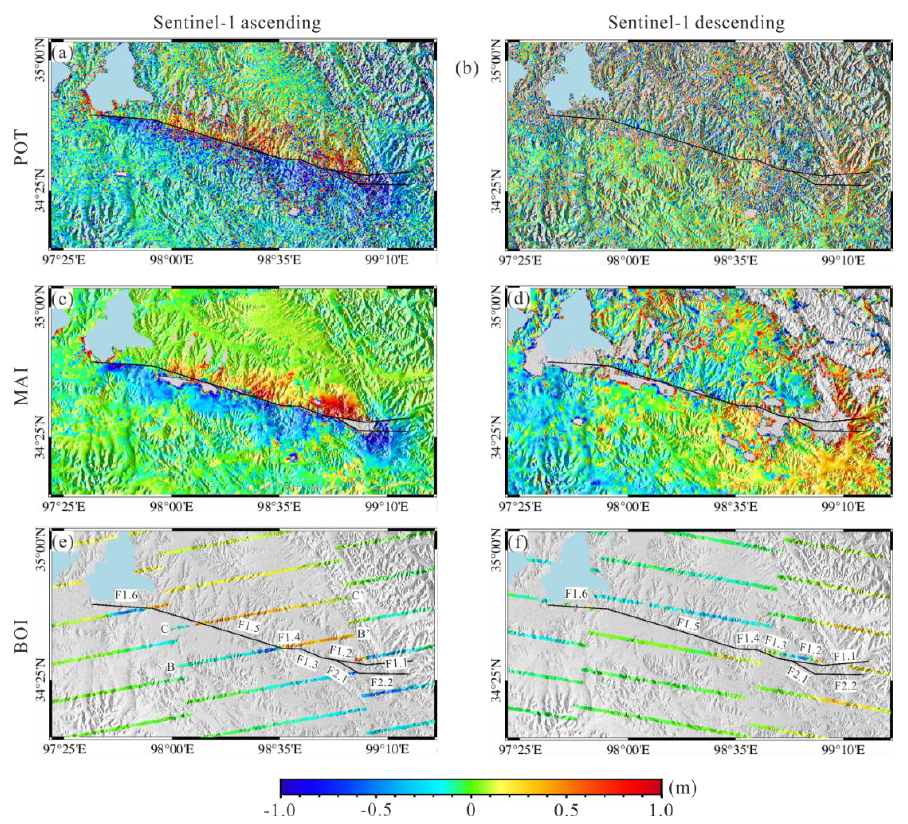
Figure 3. Along-track displacements of the 2021 Maduo earthquake derived from Sentinel-1 TOPS data; we utilized POT method for ascending ( a ) and descending ( b ) tracks, azimuth offsets derived from ascending ( c ) and descending ( d ) tracks, and BOI for ascending ( e ) and descending ( f ) tracks. The black solid lines, marked by F1 and F2, indicated the two distinct fault lines extracted by POT technique. The two black dashed lines indicate the BB (cid:48) and CC (cid:48) profiles, which are used to analyze the along-track displacements in Section